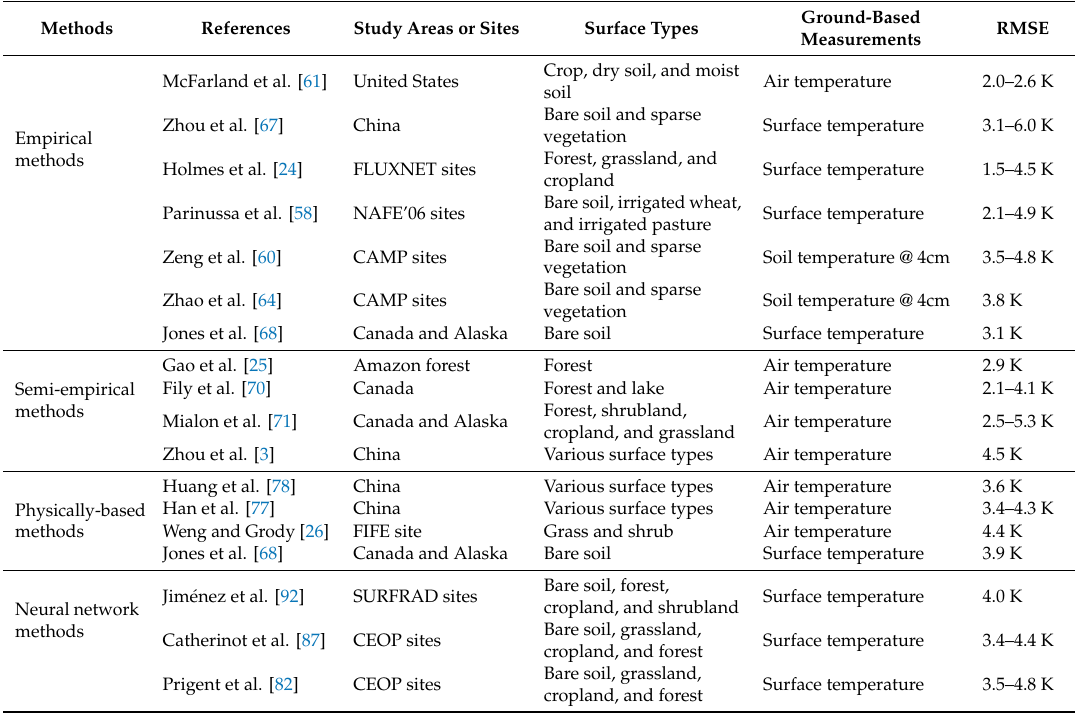
Table 2. Summary of the accuracies of di ff erent methods for retrieving land surface temperature (LST) from PMW satellite